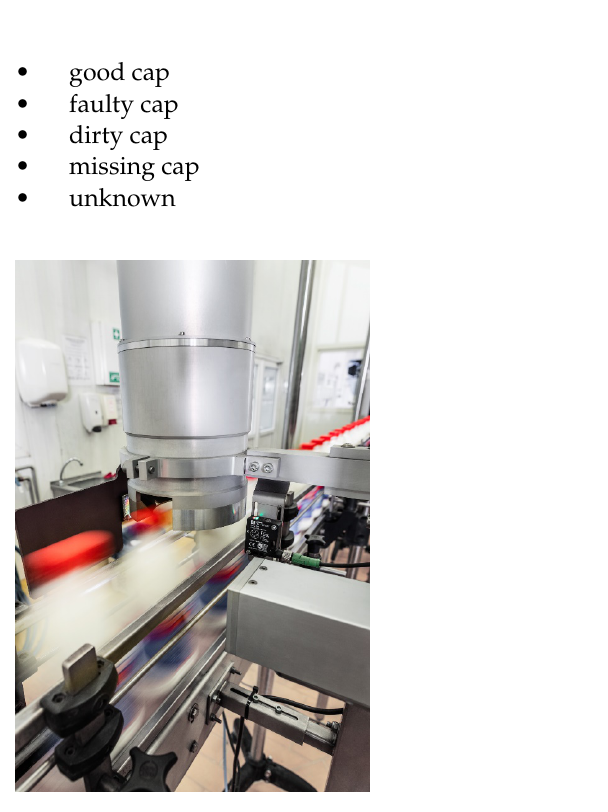
Figure 1. Inspect360+ head installed in the production